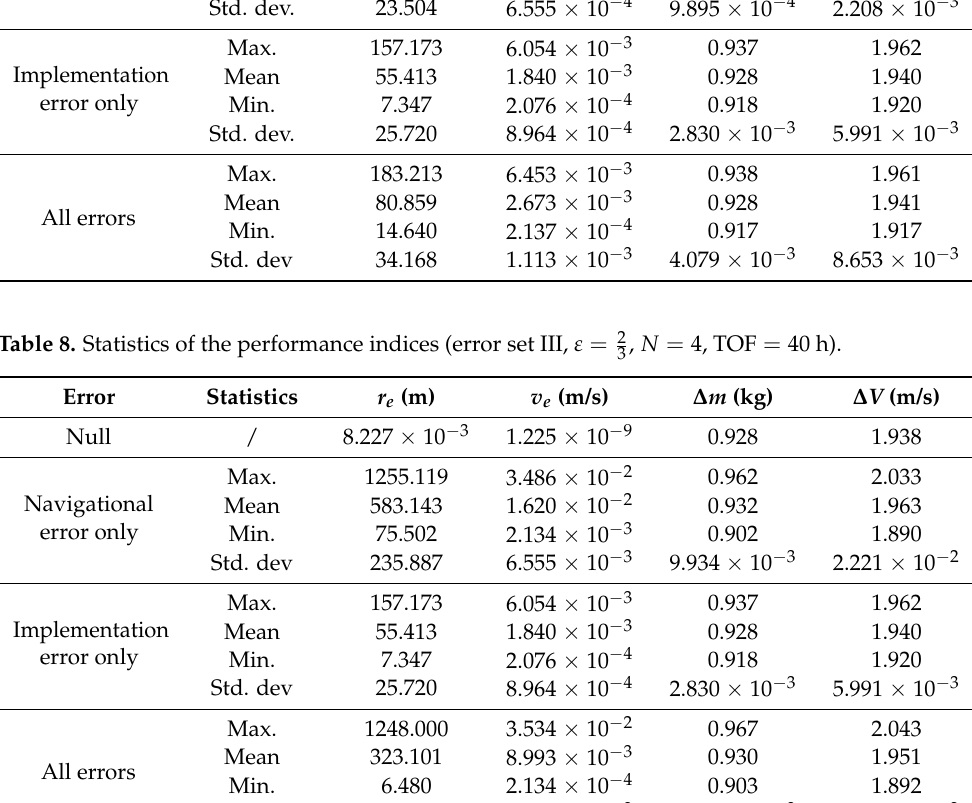
Table 9. Statistics of the performance indices (error set IV, ε = 2